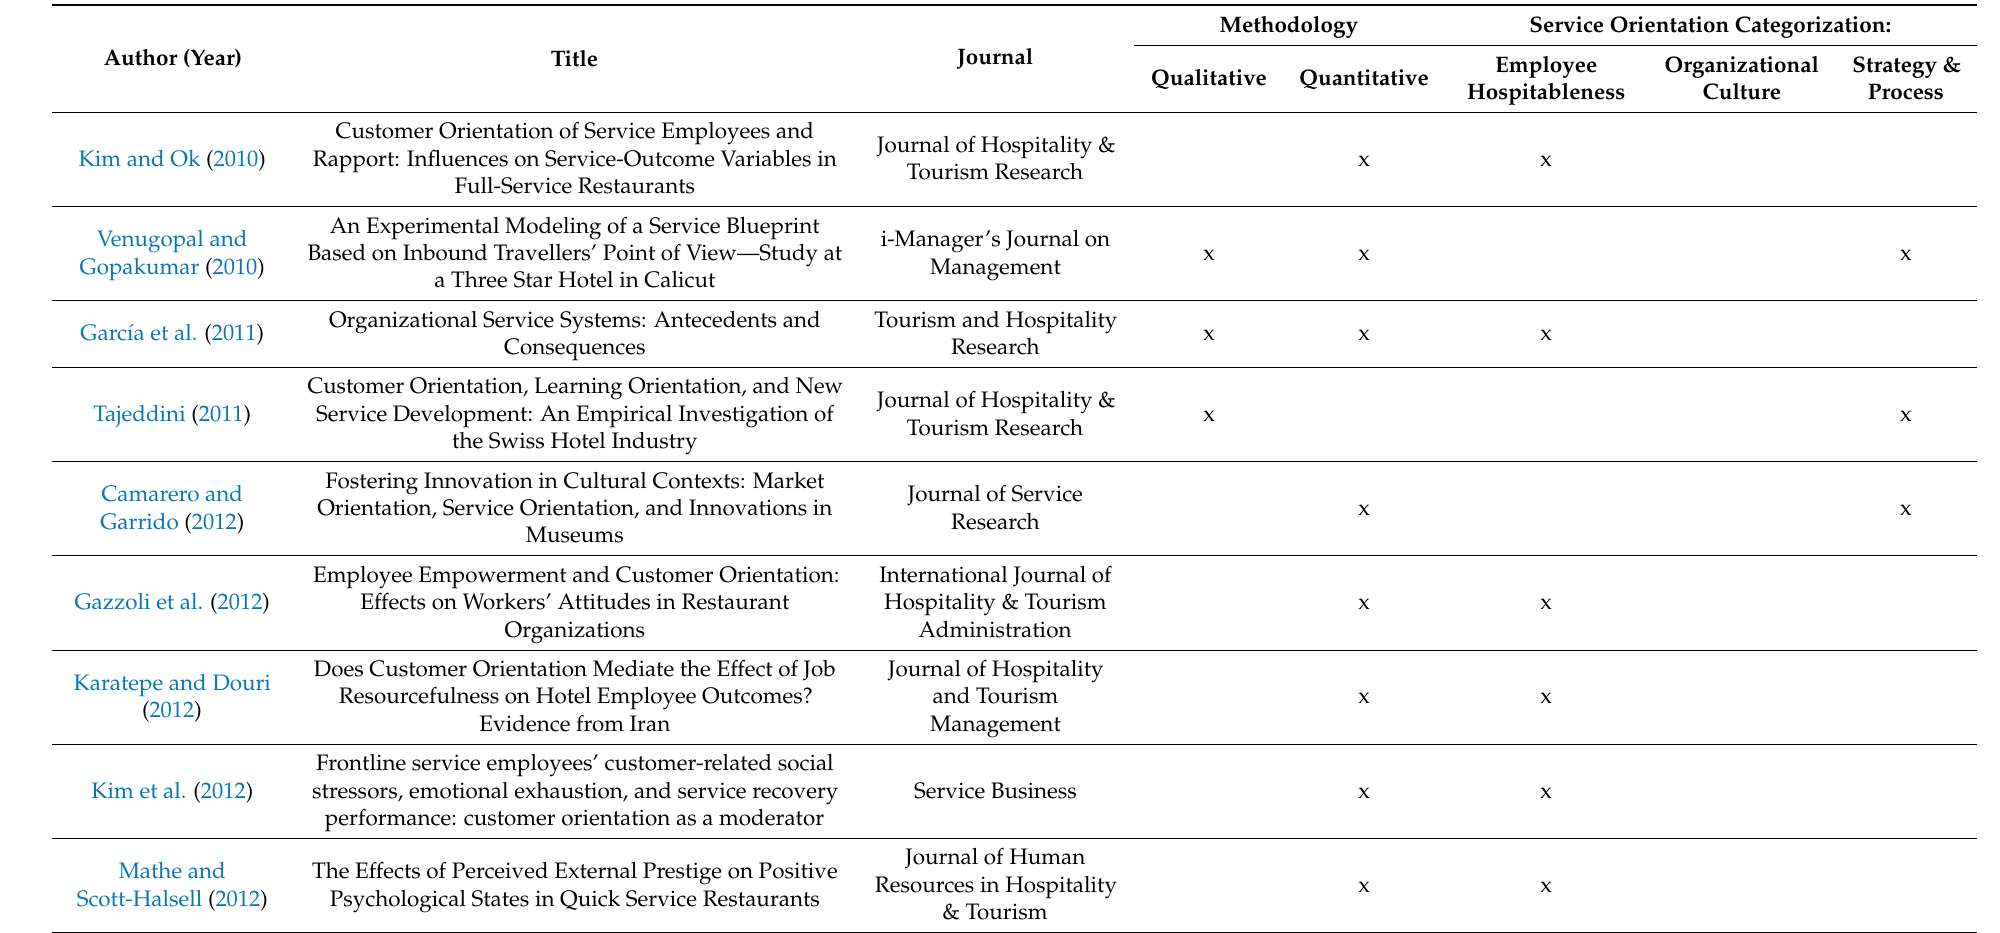
Table A1. Complete list of sample articles and their